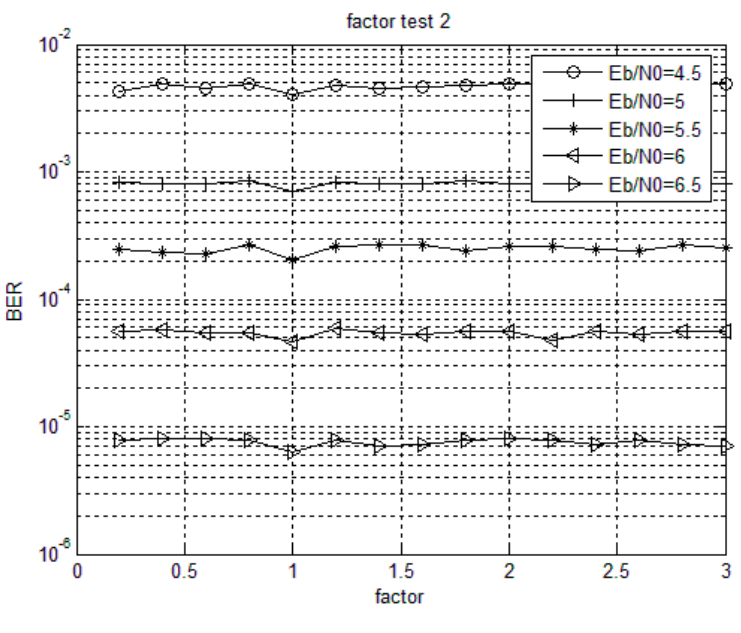
Figure 4. Code 2 weighted factor test.